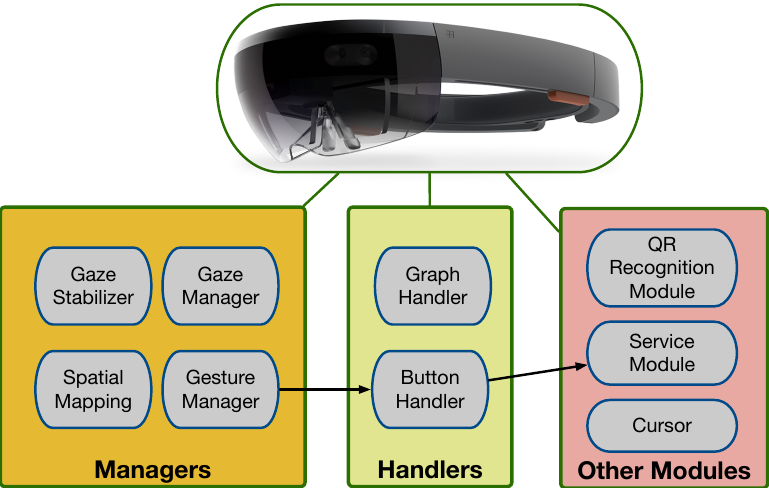
Figure 5. Main HoloLens modules used by the implemented